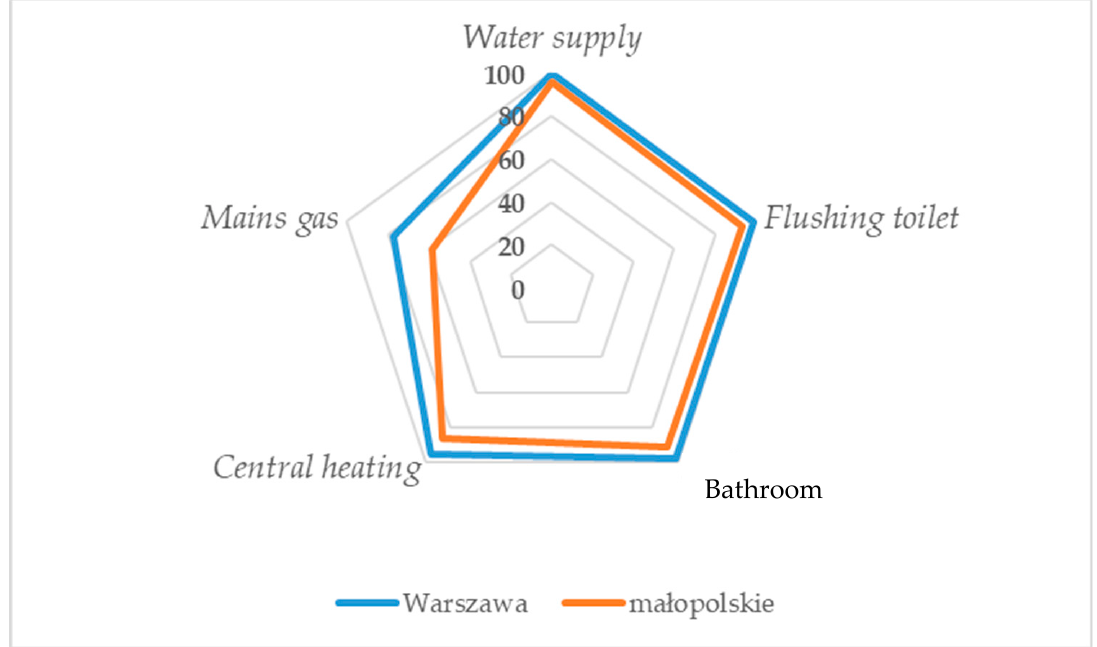
Figure 15. Indicators of housing infrastructure quality in Warsaw and the Mazovian Province 490